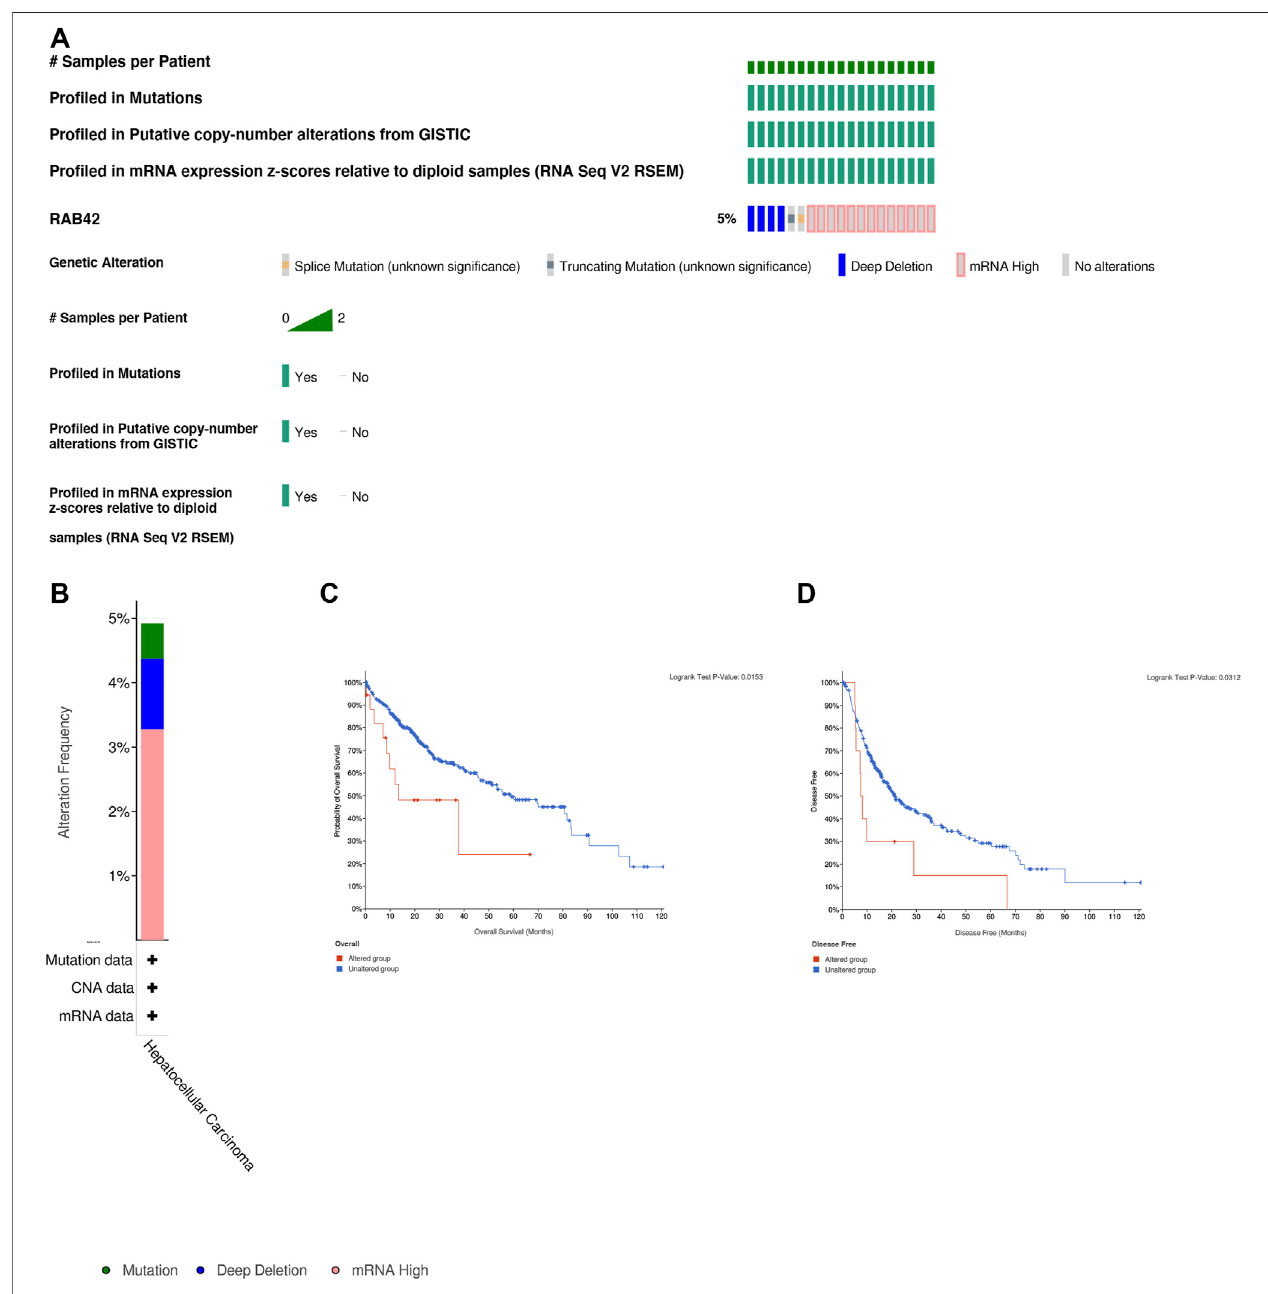
FIGURE4| GeneticalterationofRAB42inHCC. (A) OncoPrintsummarizedthegeneticalterationinRAB42basedonLIHC(TCGA,FirehoseLegacy,379samples) from cBioPortal database. (B) The histogram showed the gene alteration frequency of RAB42 from TCGA. (C) Kaplan-Meier analysis showed genetic alterations in RAB42 were related to shorter overall survival ( p = 0.0153) in HCC patients. (D) Kaplan-Meier analysis showed genetic alterations in RAB42 were related to shorter disease free survival ( p = 0.0312) in HCC patients.